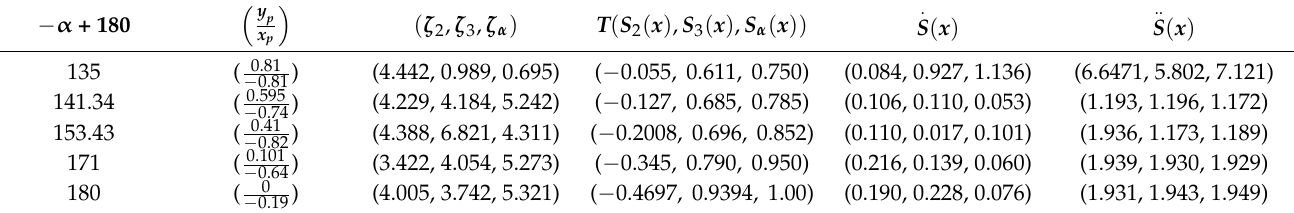
(cid:0) (cid:1) x p , y p is located in the fourth right , 𝑦 ) is lo- (cid:3043) (cid:3043) = 𝑞 = 𝑞 = 0 in the first (cid:2869) (cid:2870) (cid:2871)